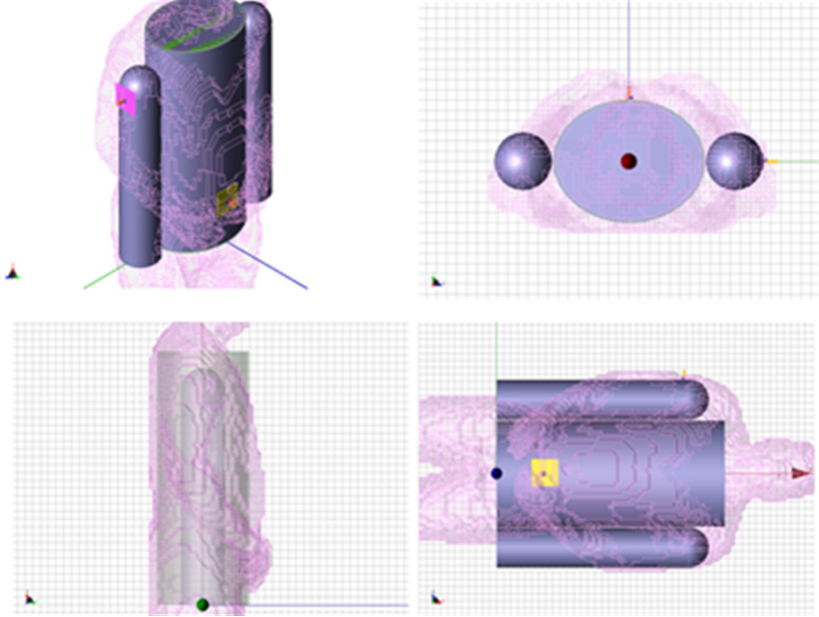
Figure 20. Simplified model superimposed on the human body numerical